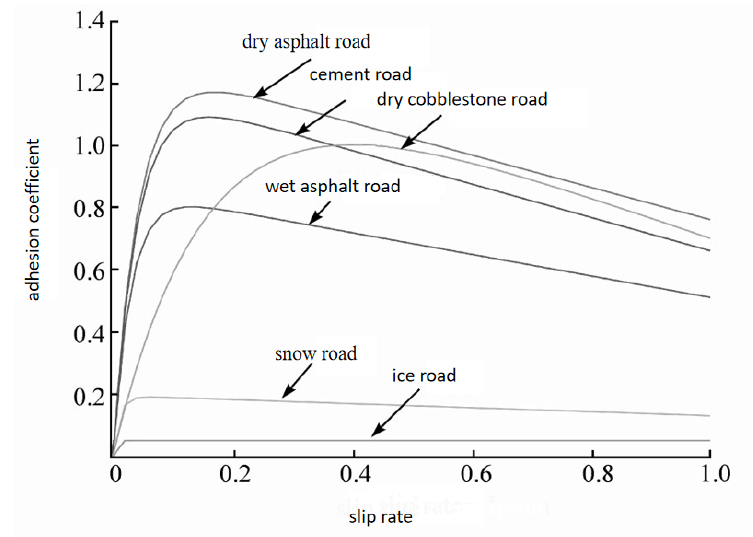
Figure 3. Relationship between slip ratio and adhesion coefficient.